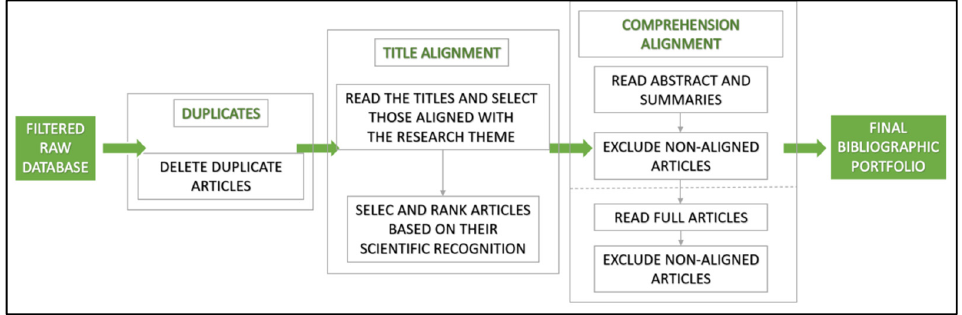
Figure 5. ProKnow-C method adapted from [18]. Description of Phase 2–Generating final biblio- graphic portfolio.